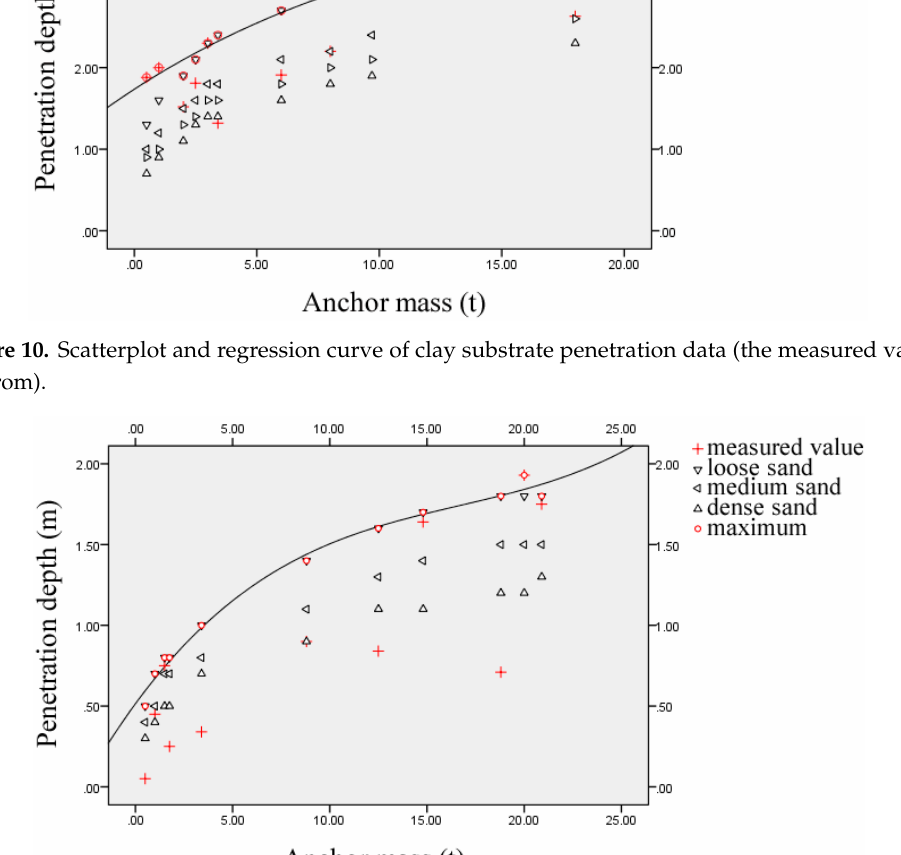
Figure 11. Scatterplot and regression curve of sand substrate penetration data (the measured values are from).